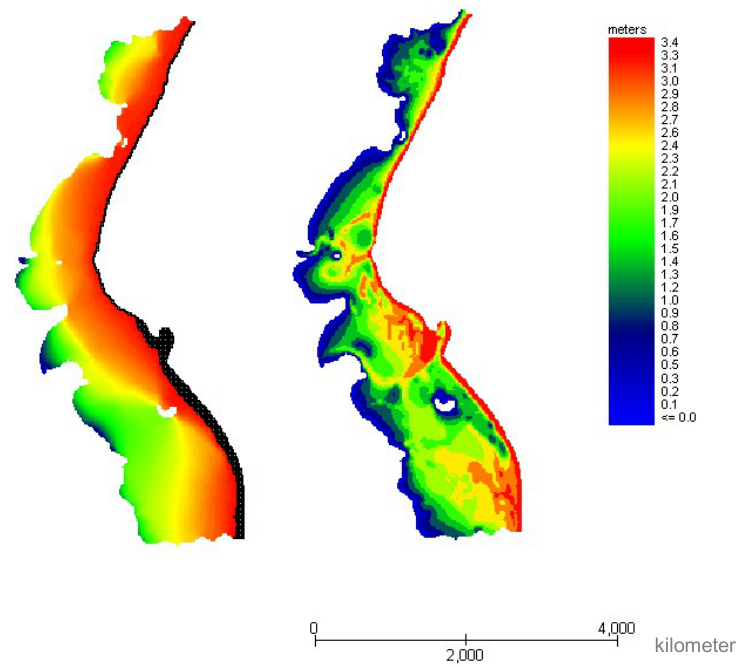
Figure 3. Maximum water surface depth and maximum flow depth in m as shown in the FLO2D model.